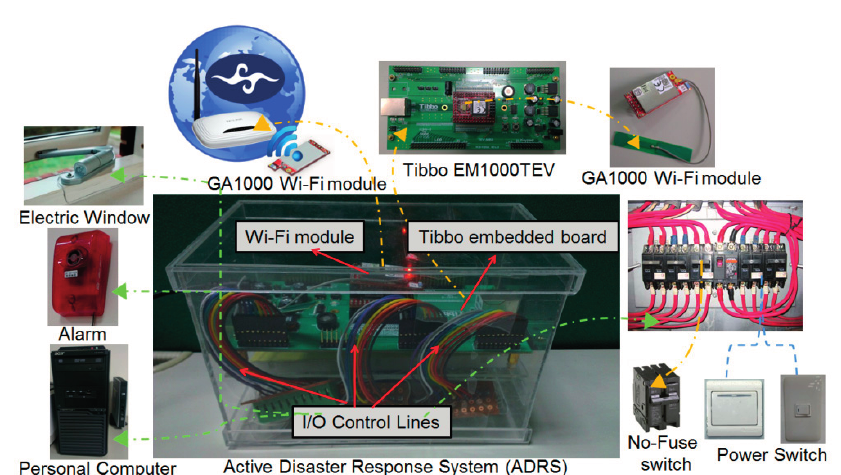
Figure 10. Prototype of ADRS.